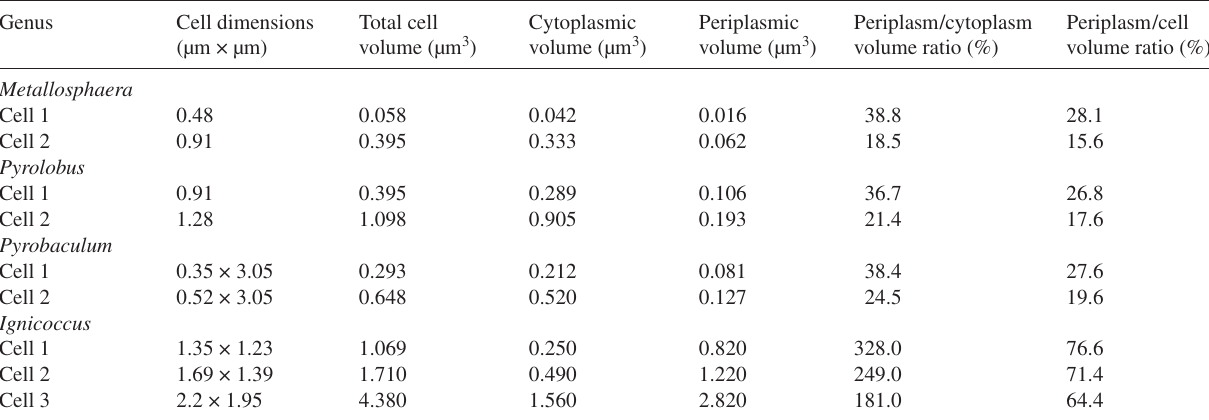
Table 1. Volume of cell, cytoplasm and periplasm in